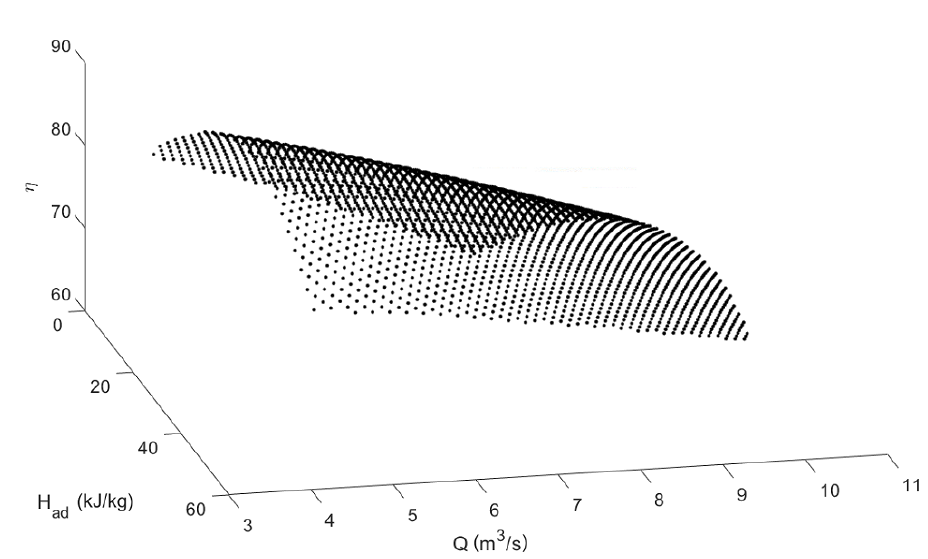
Figure 12. Rigorous relationship of compressor efficiency with compressor head and volumetric flow